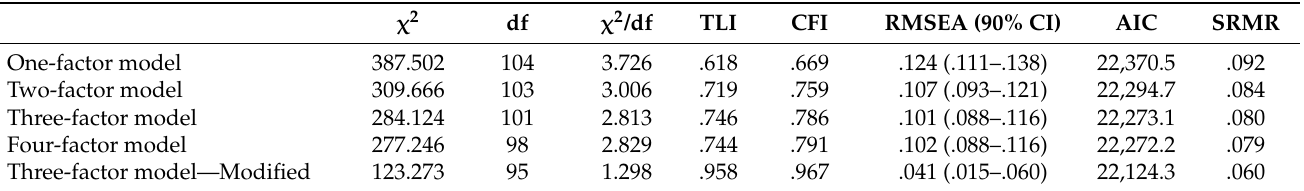
Table 3. Model description and fit statistics for CFA with all giving up, confidence, and accuracy